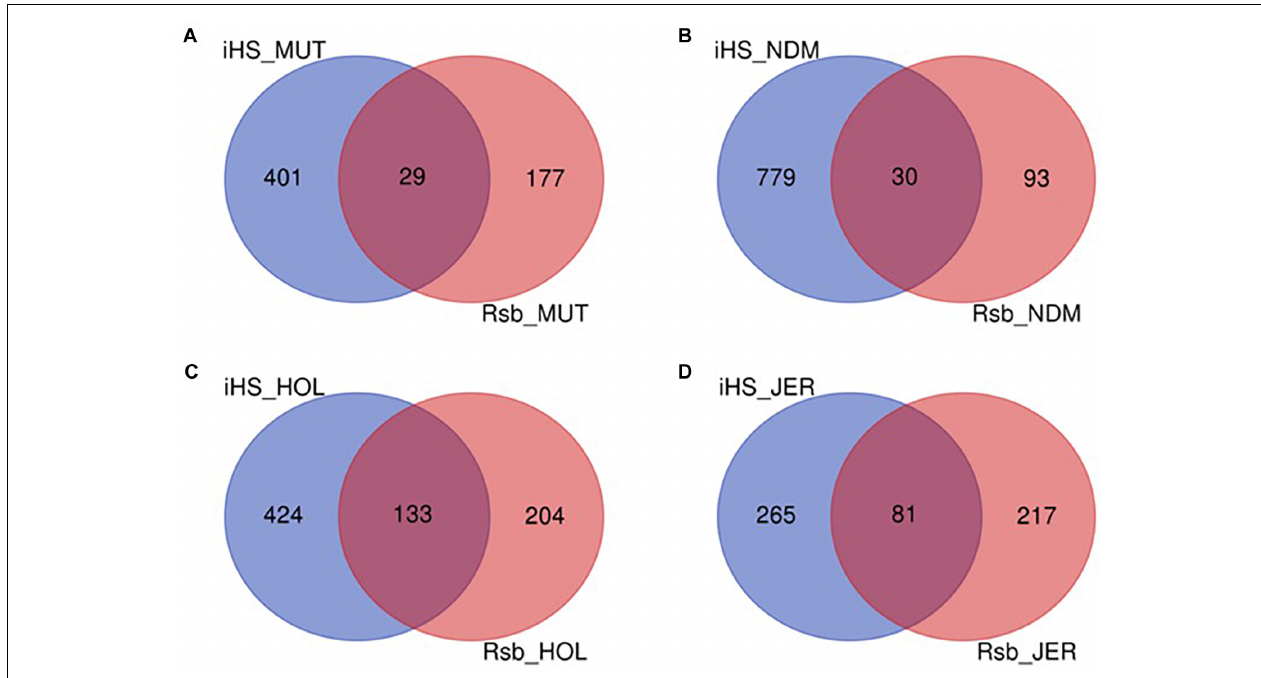
FIGURE 9 | Venn diagram showing the unique and shared candidate genes in the four B. taurus following iHS and Rsb analysis. (A) Muturu (MUT), (B) N’Dama (NDM), (C) Holstein (HOL), (D) Jersey (JER).